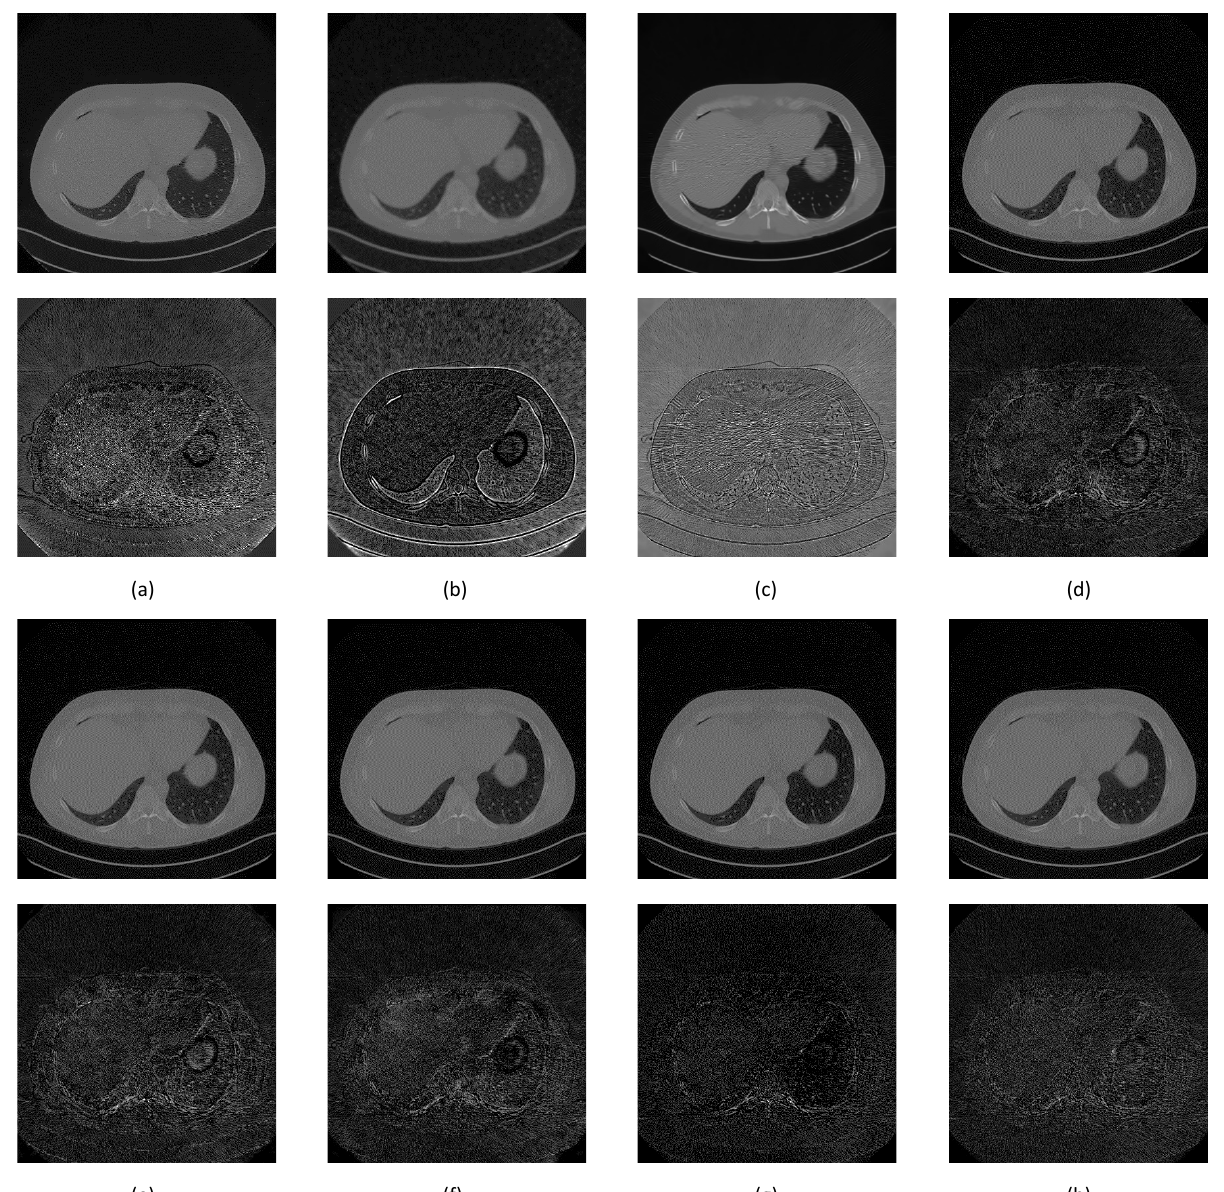
Figure 14. Image comparison between denoising methods around the diaphragm area. The first row is the denoising result while the second row is the noise mask. ( a ) NLM, 54.2858 dB; ( b ) Gaussian, 56.2689 dB; ( c ) BM3D, 58.3729 dB; ( d ) SegNet, 61.1182 dB; ( e ) DeConvNet, 61.1210 dB; ( f ) RedNet, 61.3288 dB; ( g ) U-Net, 61.2637 dB; and ( h ) S-Dual 3, 61.8016